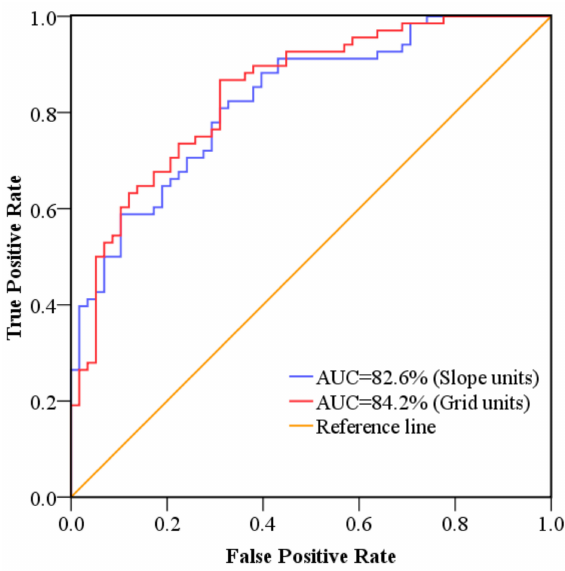
Figure 9. Receiver operating characteristic (ROC) curve evaluation of the two